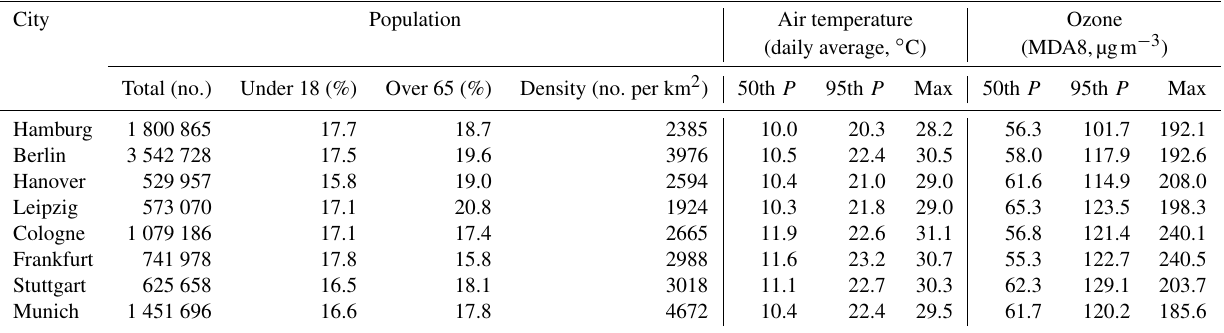
Table 1. Overview of city-specific statistics of the population (census corrected) on 31 December 2017. Statistics of air temperature and ozone concentrations are based on data from selected measurement sites during the years 2000 to 2017 (Table A1, Fig. A1). Cities are sorted from north to south; P refers to percentile. Sources are as follows: population data from DESTATIS (2019), air temperature from DWD (2019), and ozone concentrations from the German Environment Agency (UBA), based on original data from air quality monitoring networks of the German federal